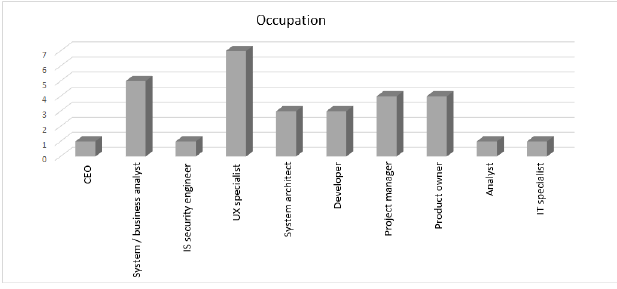
Fig . 1. Positions held by the respondents in the UX analysis